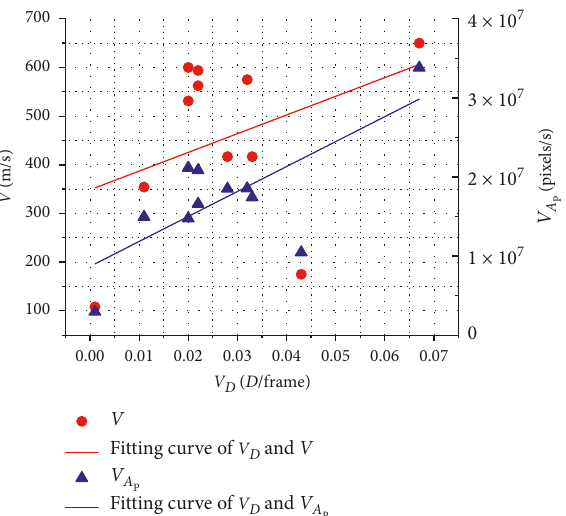
Figure 10: Relationship between V , V